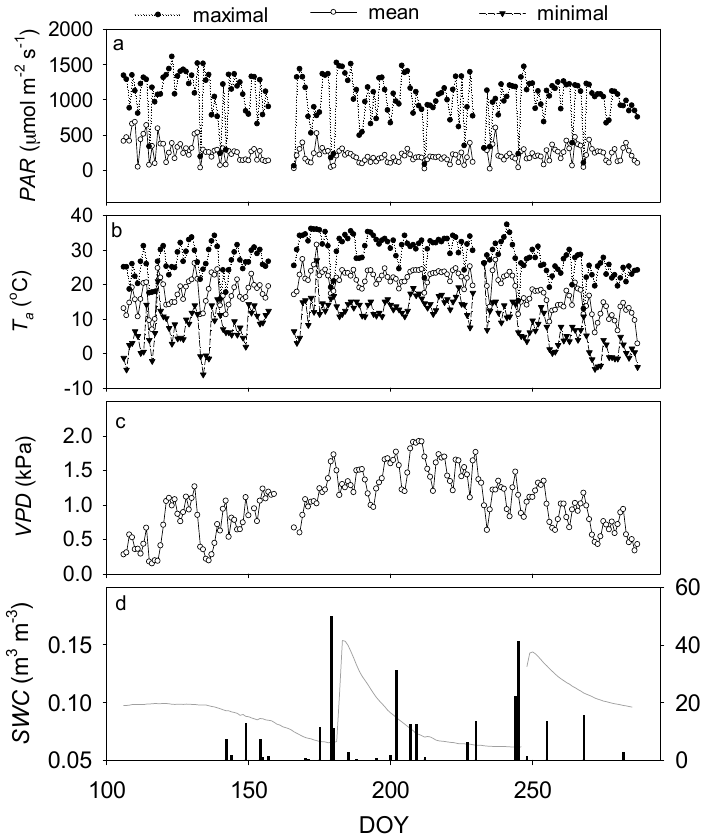
Figure 2. Seasonal variation in maximum, minimum, and mean daily photosynthetically active radiation ( PAR , ( a )) and air temperature ( T a , ( b )), daily mean vapor pressure deficit ( VPD , ( c )), and daily mean soil water content at 0.7-m depth ( SWC , ( d ); grey line) and daily precipitation (( d ); column) from 15 April to 13 October 2012. Breaks in the SWC timeseries overlap periods of missing data. Here, spring refers to DOY (day of year) 106–152, summer DOY 153–244, and autumn DOY 245–287.